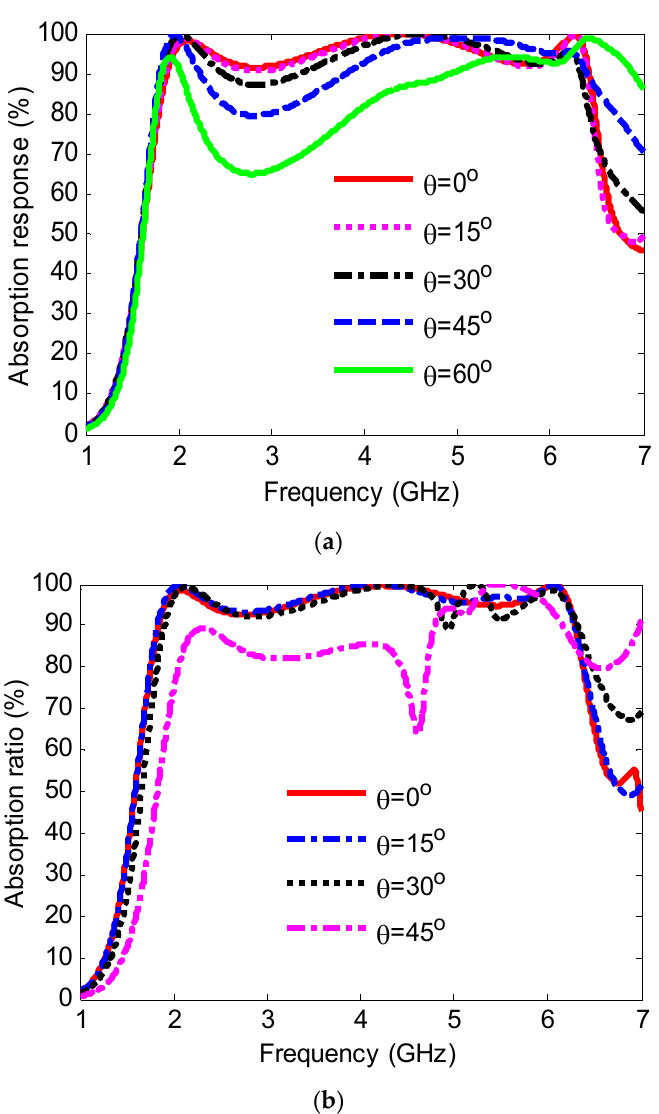
Figure 8. Simulated absorption ratio for various incident angles: ( a ) TE-polarized and ( b ) TM-polarized.